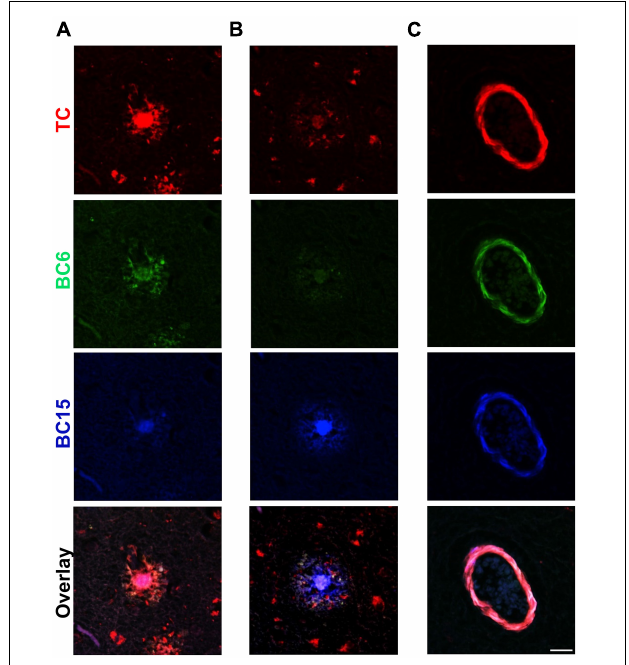
FIGURE 7 | Triple-staining of different types of A β deposits. TC (50 µ M), BC6 (50 µ M), and BC15 (1 mM) were used simultaneously to stain plaques in 10 µ m sections from the frontal cortex of an AD patient. Merge of the three channels shows differential staining for different types of A β deposits by the three dyes. (A) Triple staining of an A β plaque in frontal cortex section with TC, BC6, and BC15 shows most intense staining by TC. (B) Triple staining of a different A β plaque by the three dyes in frontal cortex section shows most intense staining by BC15. (C) Triple staining of vascular amyloid deposits in frontal cortex section shows similar intensity of staining by the three dyes. Scale bar 25 µ